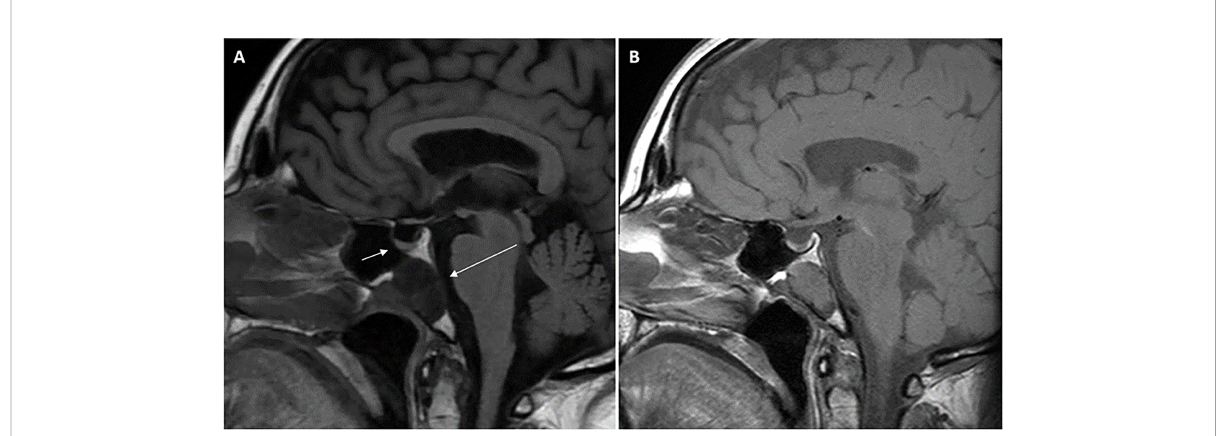
FIGURE 1 Magnetic resonance imaging (MRI) scans of the head demonstrating midline sphenoid bone mass. T1-weighted (FLAIR) sagittal view pituitary magnetic resonance imaging (MRI) scan performed in 2021 (A) demonstrating normal pituitary gland (short arrow) and adjacent midline T1-hypointense 3.0 cm × 2.3 cm × 2.3 cm mass (long arrow) located within the sphenoid bone extending to the clival, sphenoid sinus, and nasopharyngeal surfaces of the sphenoid bone with no extension into the sphenoid sinus or nasopharynx. Retrospective review of the T1-weighted sagittal view initial pituitary MRI scan performed in 2014 (B) demonstrated the same lesion within the sphenoid bone measuring 2.2 cm × 2.1 cm × 2.3 cm. Arrows are not included in (B) so the image is unperturbed and seen in the same way the radiologist viewed the